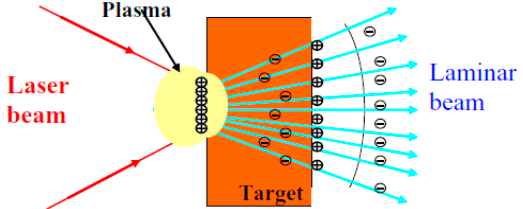
Figure 2. A simple sketch of ion beam generation, and acceleration by the Target Normal Sheath Acceleration (TNSA) mechanism, showing the extreme laminarity of the beams. At this stage the beams are not neutral although quasi-neutrality becomes evident further from the